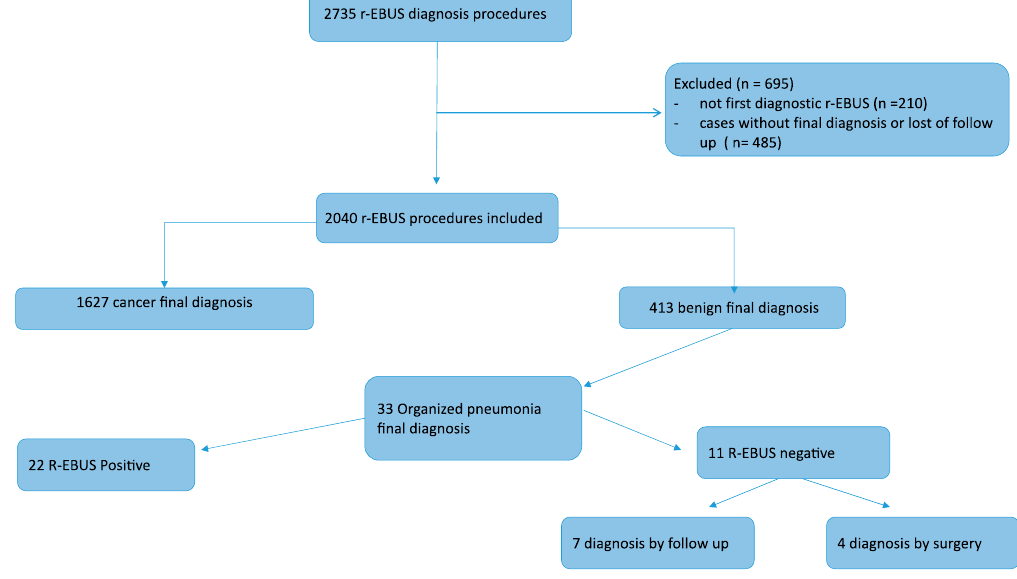
Figure 1. Flowchart.